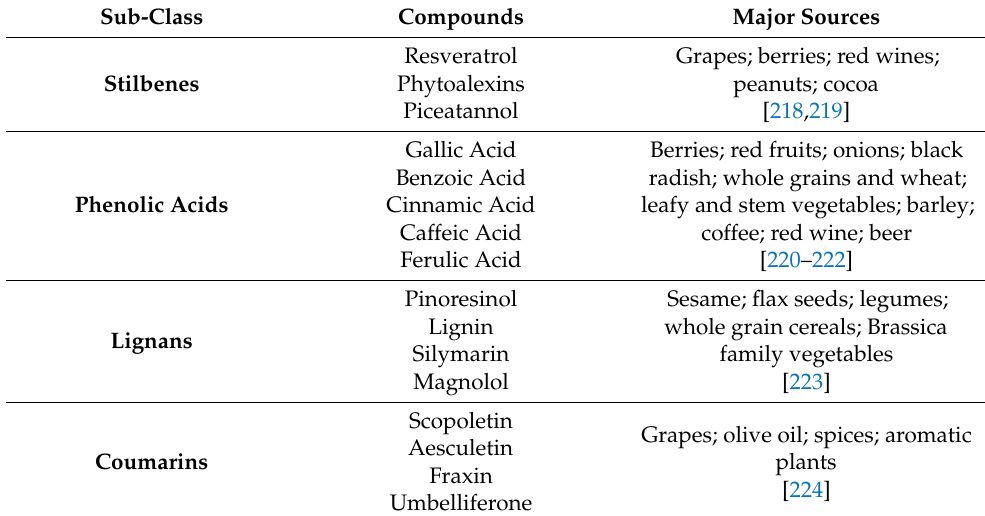
Table 2. Sub-classes of non-flavonoid phenolic compounds, examples of compounds for each sub- class, and their main dietary